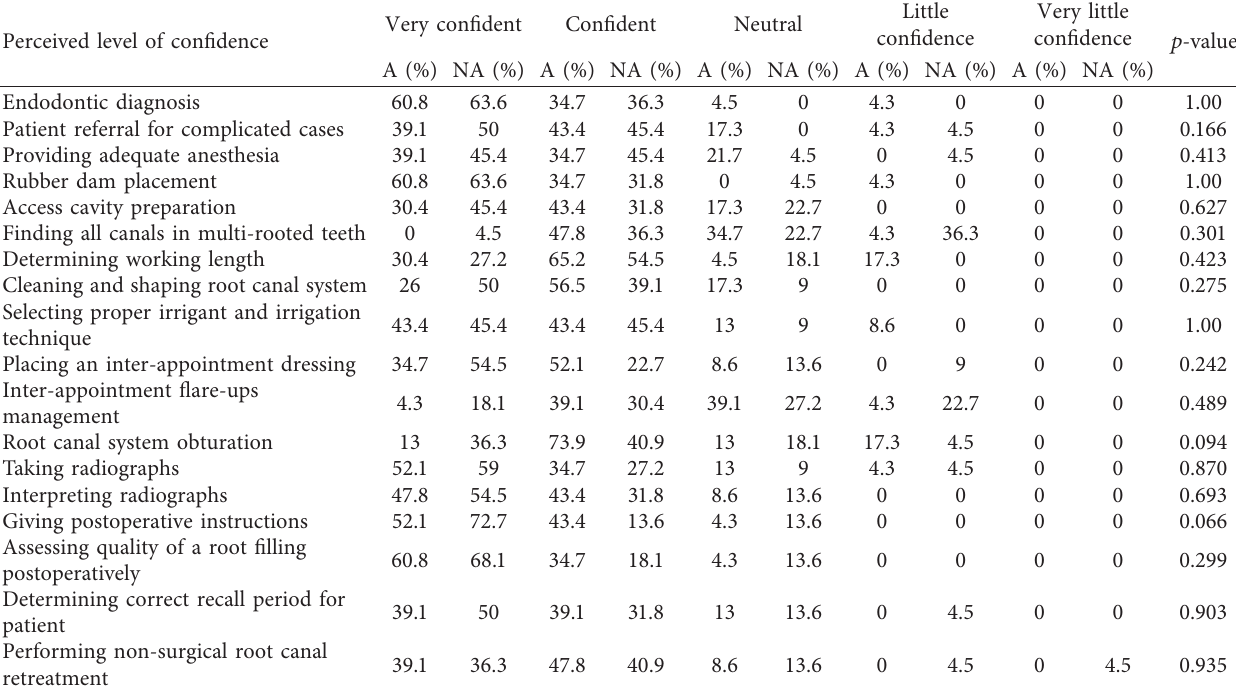
Table 3: Self-evaluated level of confidence in performing different stages of root canal treatment among elective course attendees (A) and non-attendees (NA).